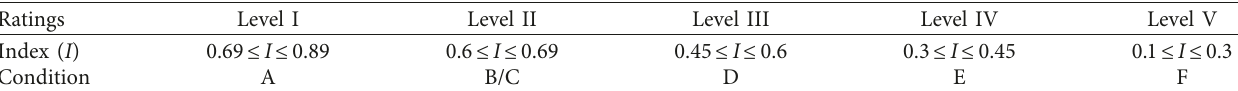
Table 2: Ratings and